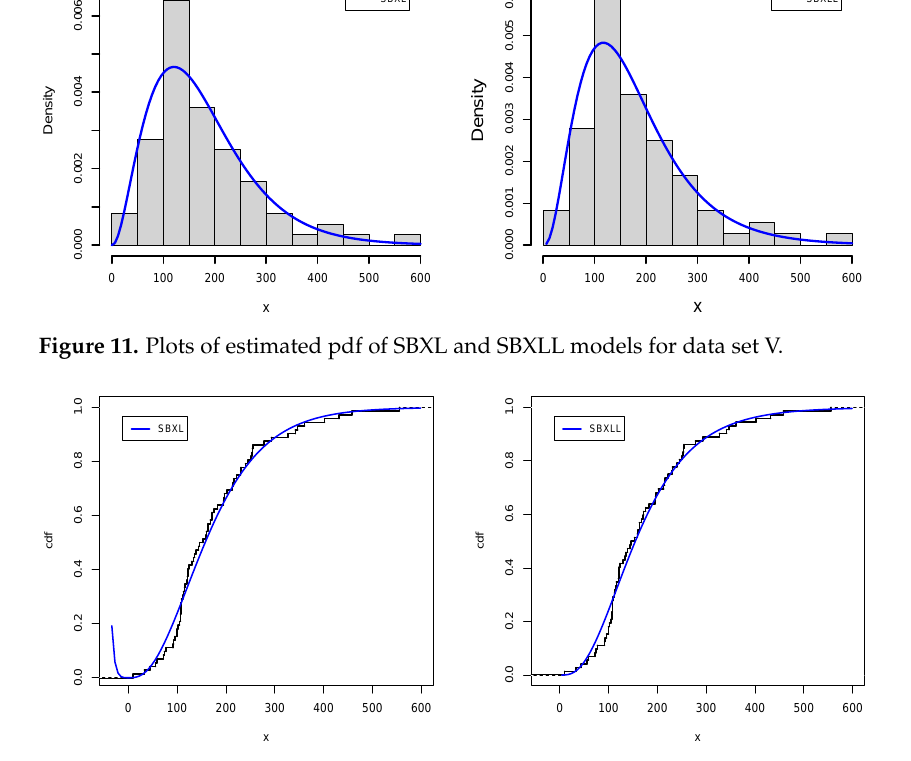
Figure 12. Plots of estimated cdf of SBXL and SBXLL models for data set